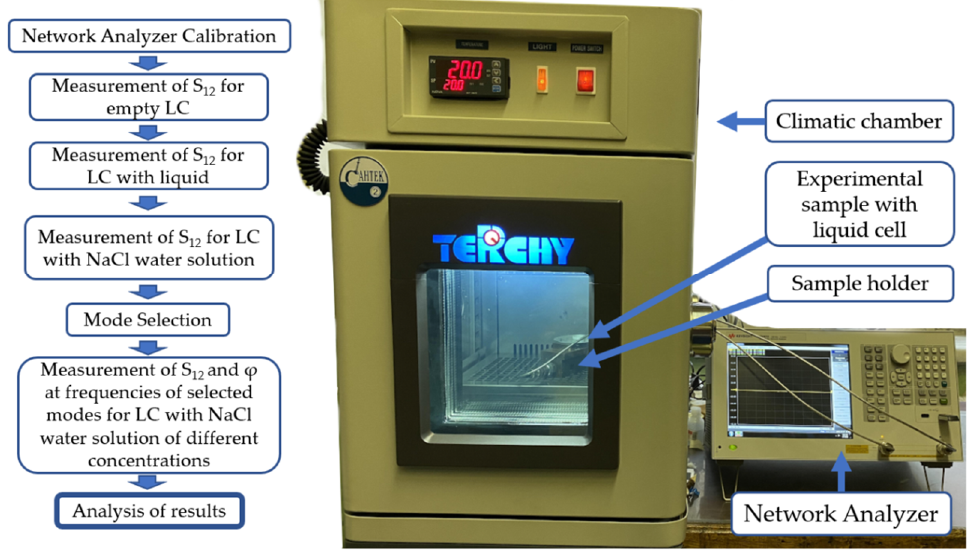
Figure 2. Flow chart of the experiments and schematic view of the experimental setup. Water solutions of NaCl are used as test liquids with variable conductivity changed from σ = 0 (distilled water) to σ = 10 S/m (7.6 weight % NaCl in water) by changing weight per cent of the solution components. Viscosity (<13%), density (<8%), and permittivity (<1%) of the solutions are almost constant [38] and do not contribute much to the conductivity responses.